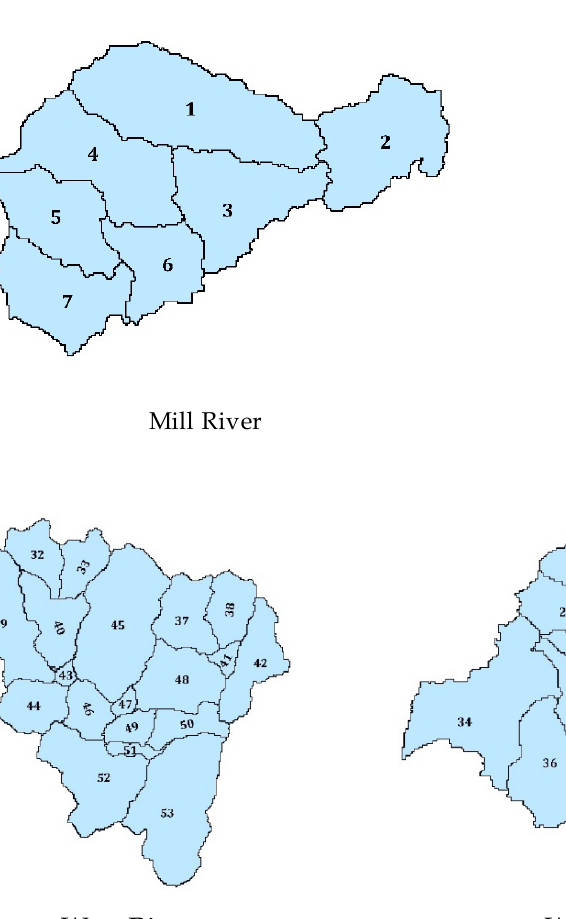
Figure 2. The westernmost Mill River watershed has seven subbasins (1–7), the eastern- most Bear River has three (8, 9, 18), and similarly for the other watersheds as depicted in the Figure. The “Output” file of the simulated model contained all hydrological parame- ters’ values including groundwater recharges (mm) on a monthly timescale for all the 53 subbasins. The results were spatially and temporally aggregated for better understanding.